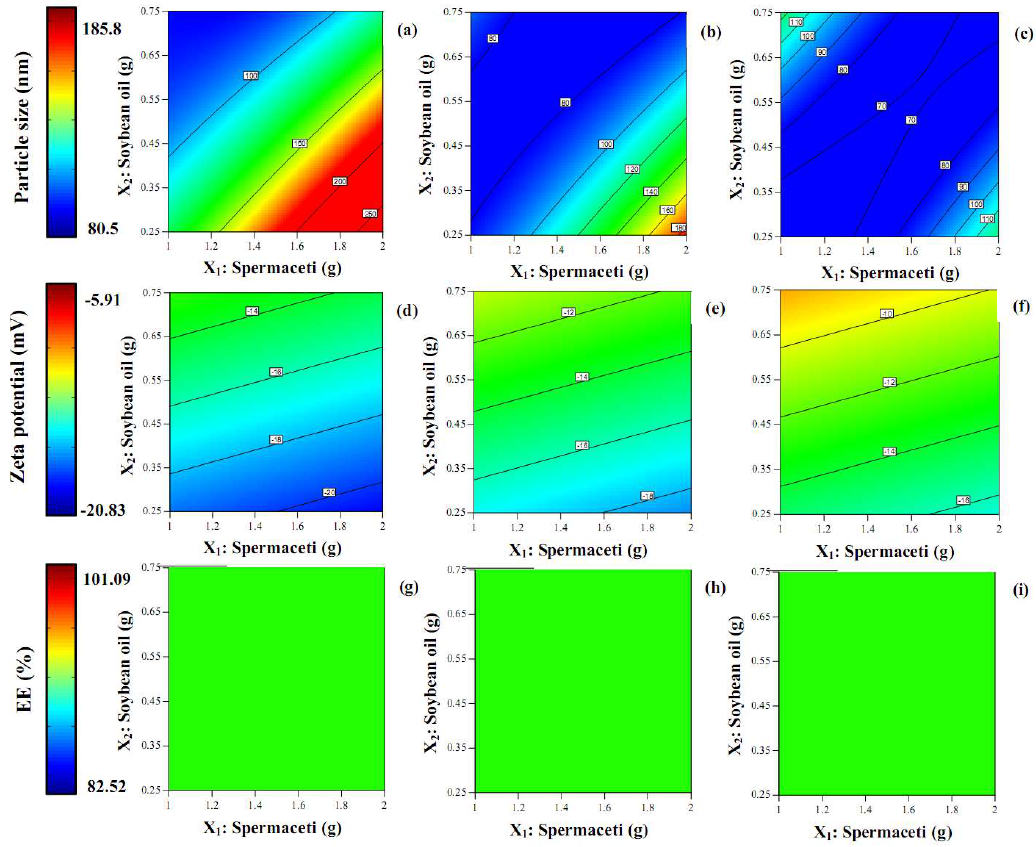
Figure 2. The contour plots of the triamcinolone acetonide-loaded nanostructured lipid carriers for particle size ( a – c ); zeta potential ( d – f ); %EE ( g – i ) and Tween 2 g (left column), Tween 3 g (middle column), and Tween 4 g (right column).